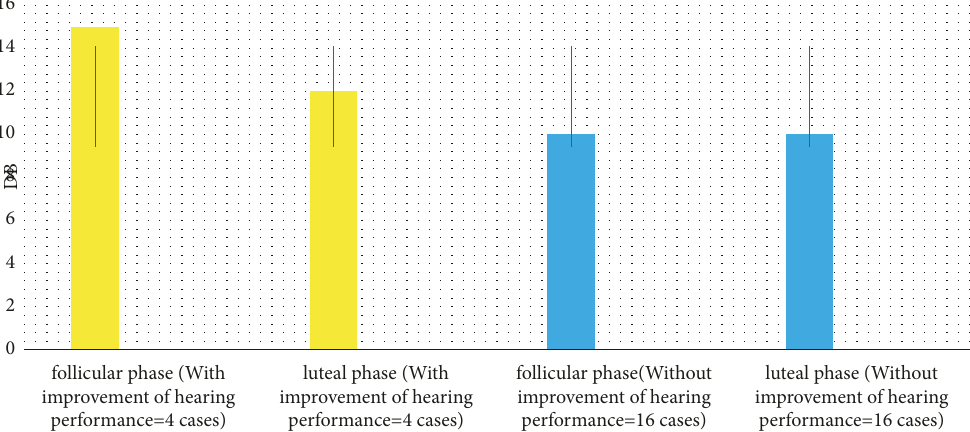
Figure 1: Mean DPOAEs of twenty healthy female in follicular-luteal phase.